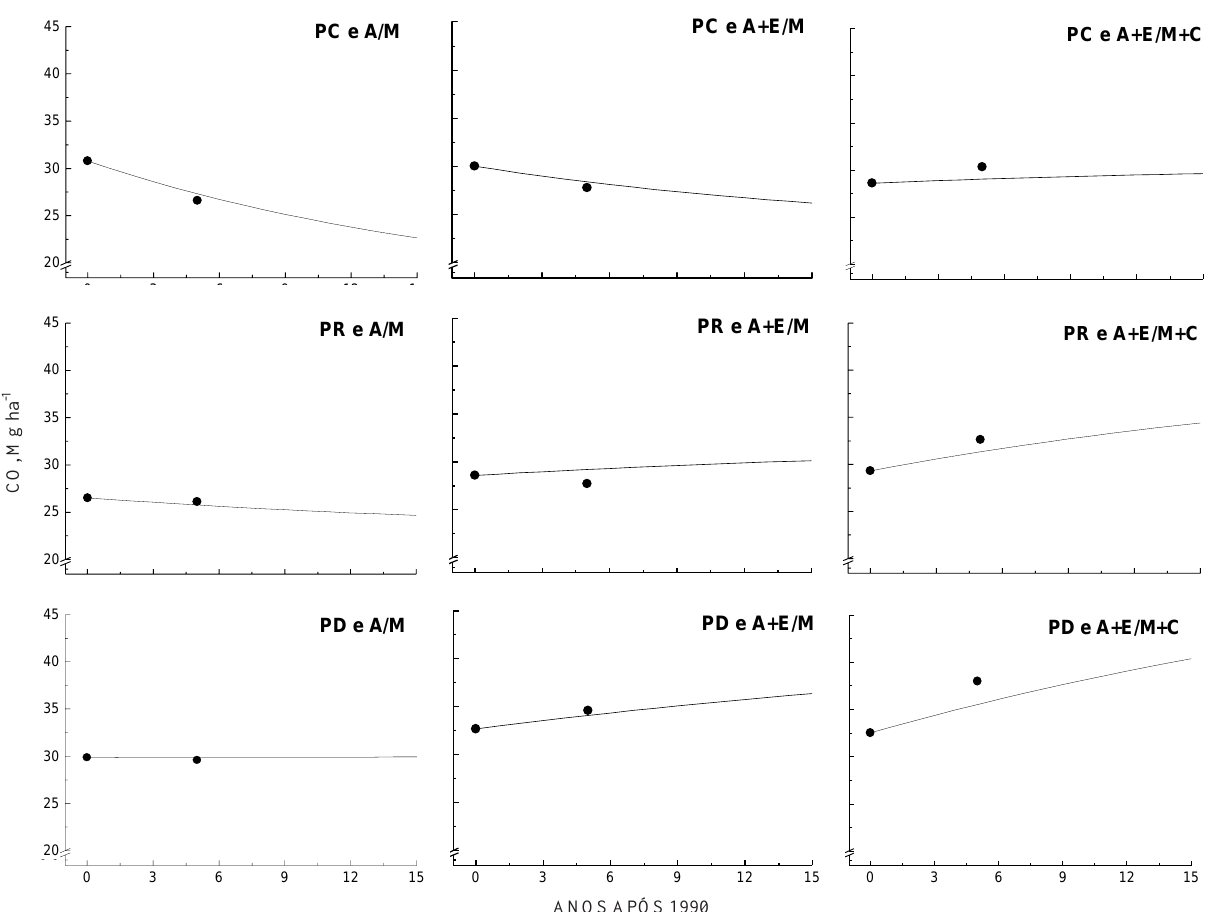
Figura 1. Simulação do efeito dos sistemas de preparo e de cultura sobre os estoques de carbono orgânico (CO) da camada de 0-17,5 cm do solo, durante quinze anos (1990-2005), por meio do ajuste do modelo C = C + (C - C ) e -K2.t . Linhas correspondem aos valores estimados pelo modelo e os pontos aos dados t e o e